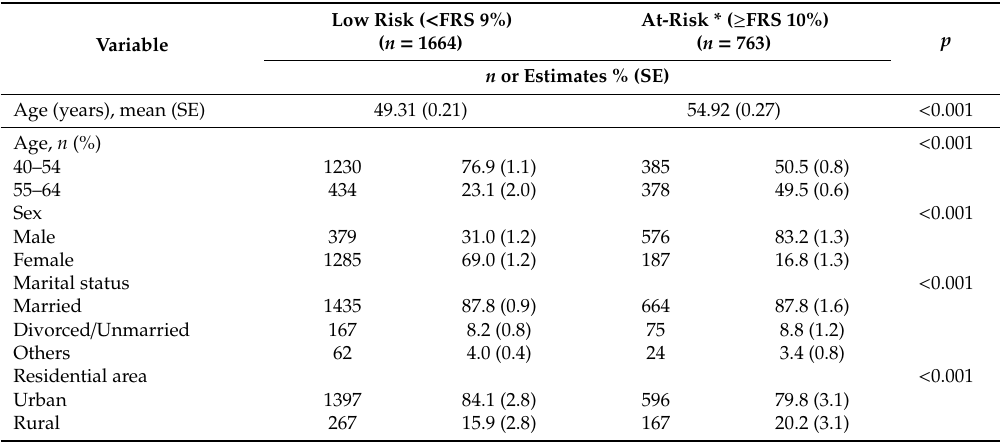
Table 1. Unweighted frequencies of demographic and health-related characteristics of the middle-aged, KNHANES